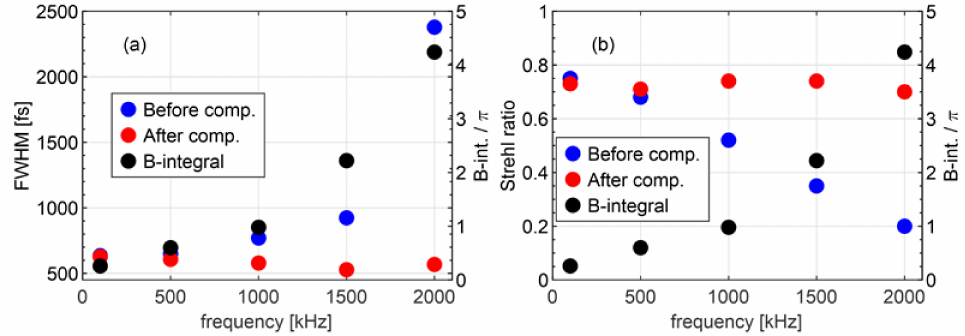
Figure 4. Figure shows the increase in pulse FWHM with increasing frequency ( a ) and decrease in pulse Strehl ratio with increasing frequency ( b ). Results presented with blue circles are the results at the reference state setting of the TCFBG parameters. The red circles are the results after the adjustment of the TCFBG parameters in order to compensate the accumulated nonlinear phase. The accumulated nonlinear phase or B-integral is presented with black